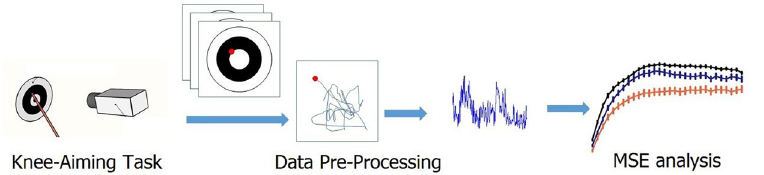
Figure 2. The flowchart of data analysis. Data gathered from the experiment first through a series of Data Pre- Processing. Then the MSE approach was further utilized to extract a novel biometrics-termed index of knee joint stability (IKJS) from the displacement time series in order to evaluate knee